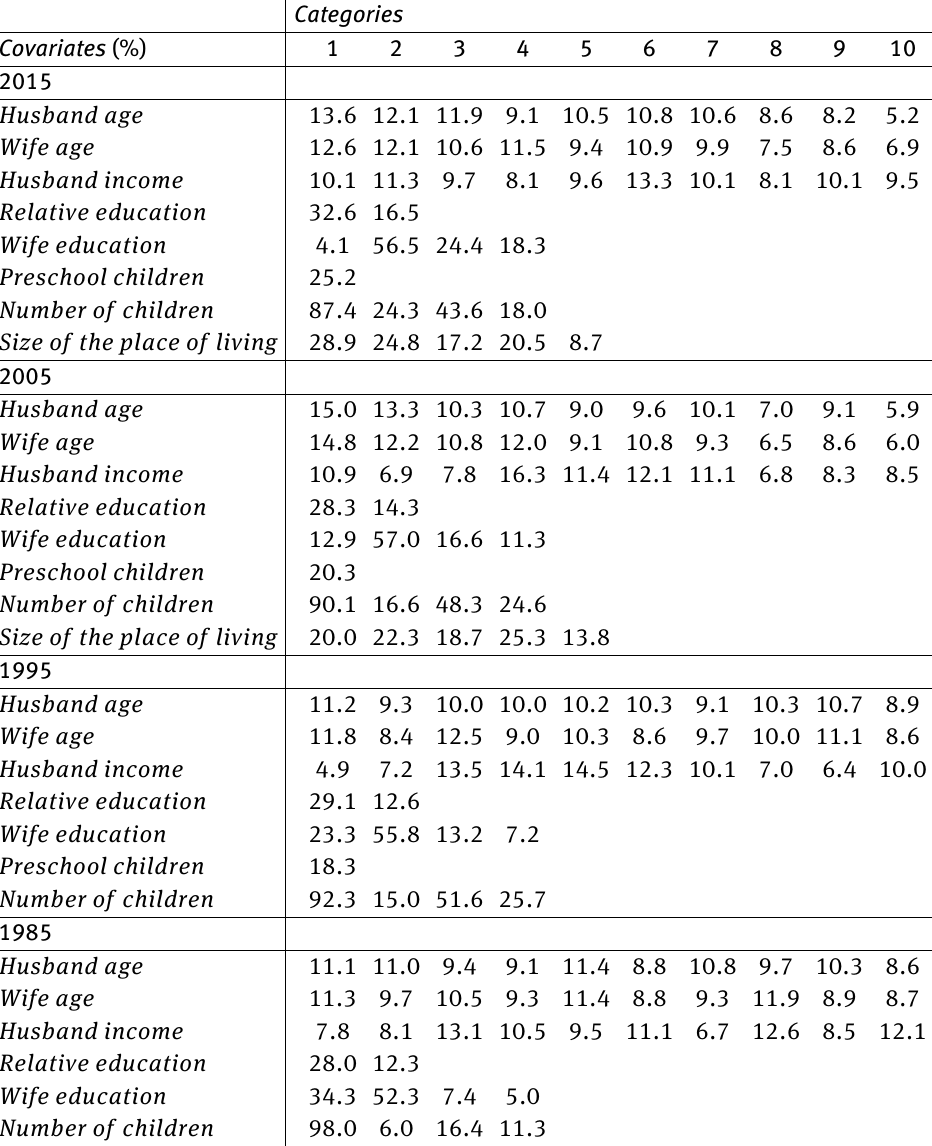
Table 3: Descriptive statistics for the categorical covariates by survey year (weighted frequencies with survey weights for years 2015 and 2005). The categories are defined in Table